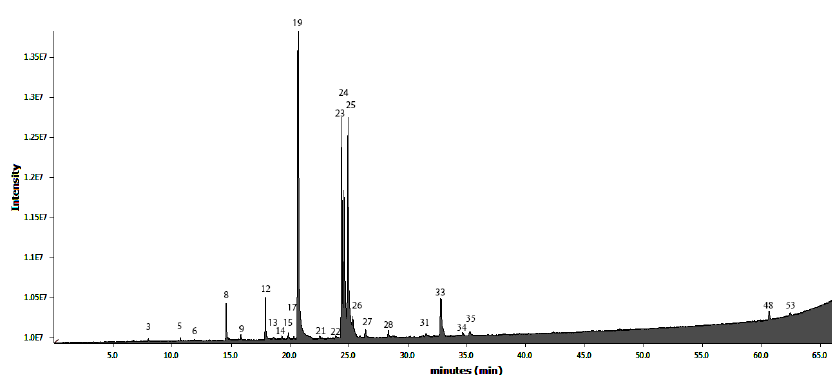
Figure 4. Volatile compounds profile of fresh apple juice.